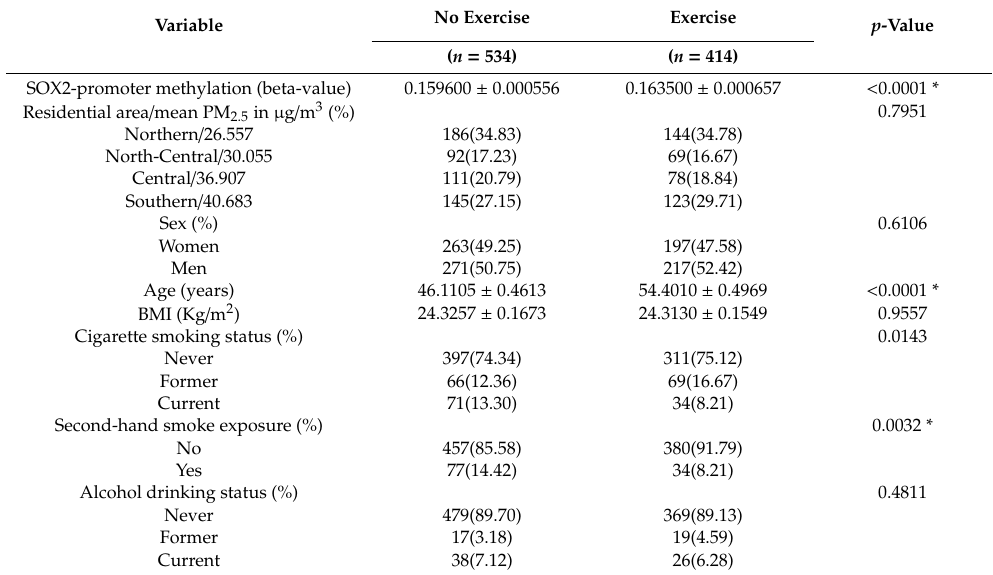
Table 1. Basic characteristics of the study participants stratified by exercise habits.